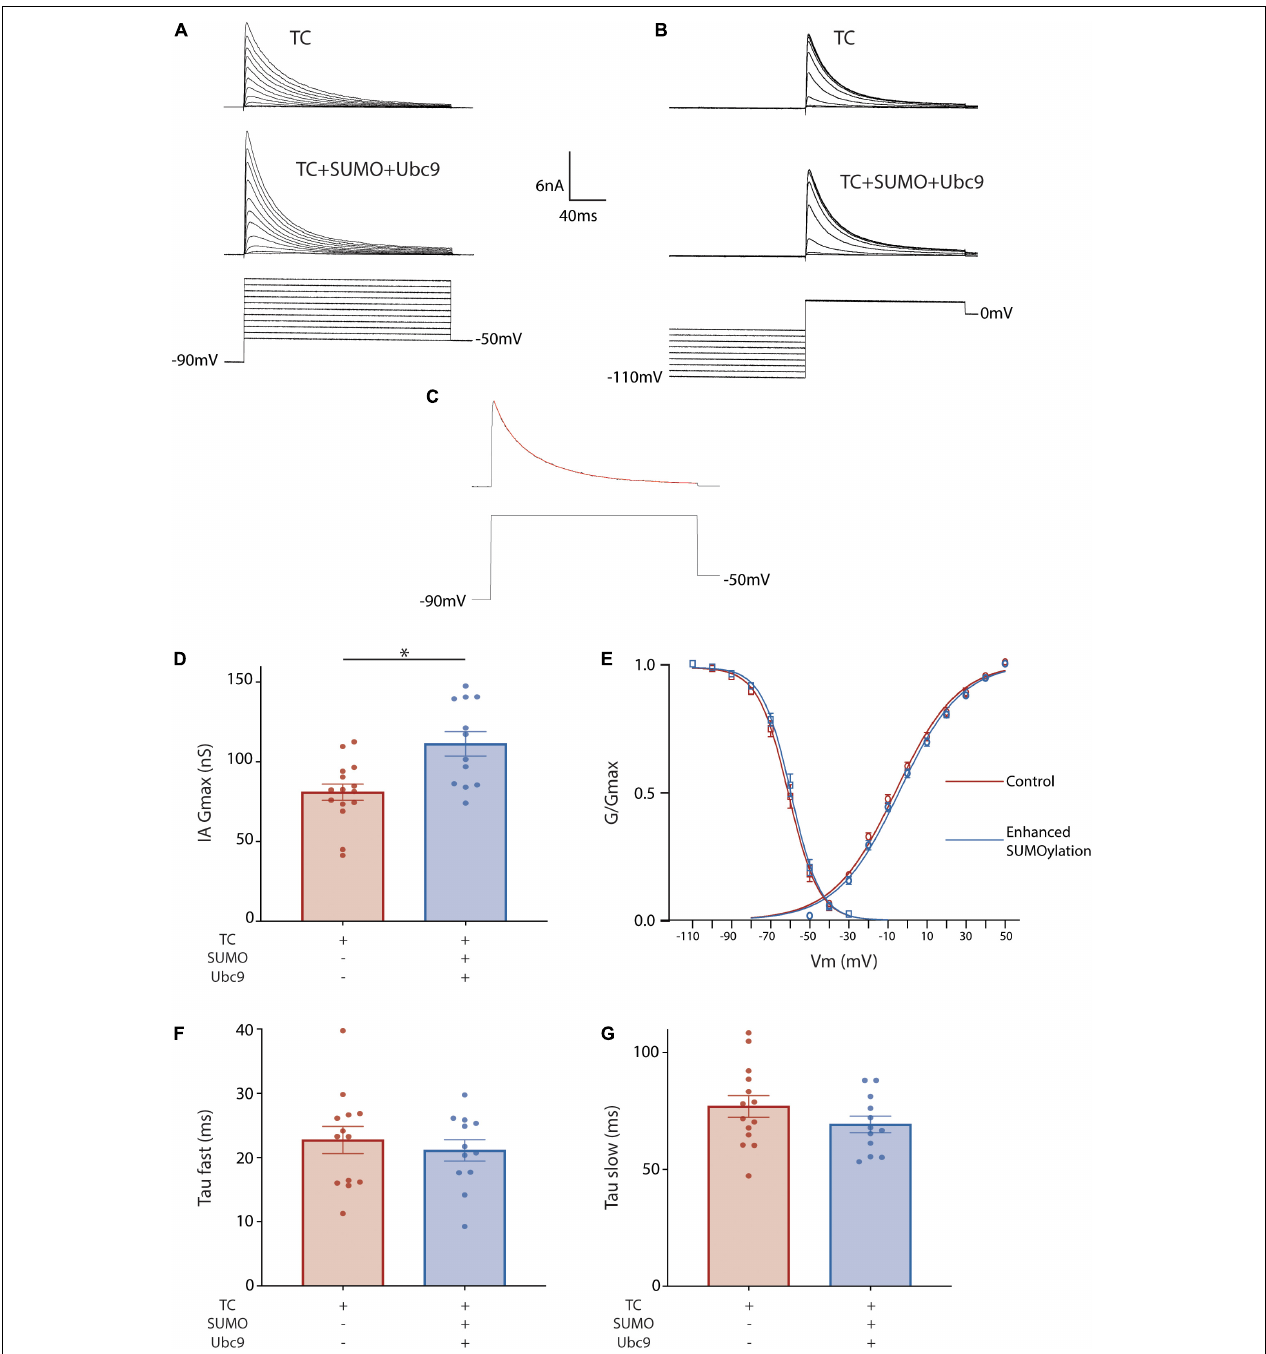
FIGURE 2 | Enhanced SUMOylation increases IA Gmax mediated by the TC. Whole cell-patch clamp recordings for HEK cells transiently transfected with Kv4.2g + HA-KChIP2a + HA-DPP10c. SUMOylation was (+) or was not (–) enhanced by co-expressing SUMO2 + Ubc9. (A) Representative current traces (upper) and voltage protocol (lower) for obtaining the voltage dependence of activation. (B) Representative current traces and voltage protocol used for obtaining the voltage dependence of steady-state inactivation. (C) Representative curve fit used for obtaining the fast and slow time constants of inactivation. (D) Plots of mean ± SEM IA Gmax. Each dot represents one cell from ≥ 3 transfections. Asterisks indicate significant differences. TC, 80.9 ± 5.1 nS vs. TC + SUMO2 + Ubc9, 111.2 ± 7.6 nS; t -test p = 0.002. (E) Activation (circle) and steady-state inactivation (square) curves. The points on the curve represent the mean ± SEM for cells shown in (D) . TC V50 Act, –5.8+1.2 mV, n = 15; TC + SUMO2 + Ubc9 V50 Act, –2.5 ± 1.4 mV n = 12; t -test, p = 0.09. TC V50 Inact, –60.8 ± 1.4 mV, n = 16; TC + SUMO2 + Ubc9 V50 Inact, –58.7 ± 1.5 mV, n = 11; t -test, p = 0.32. Error bars are plotted for all data points. Plots of the mean ± SEM fast (F) and slow (G) time constants